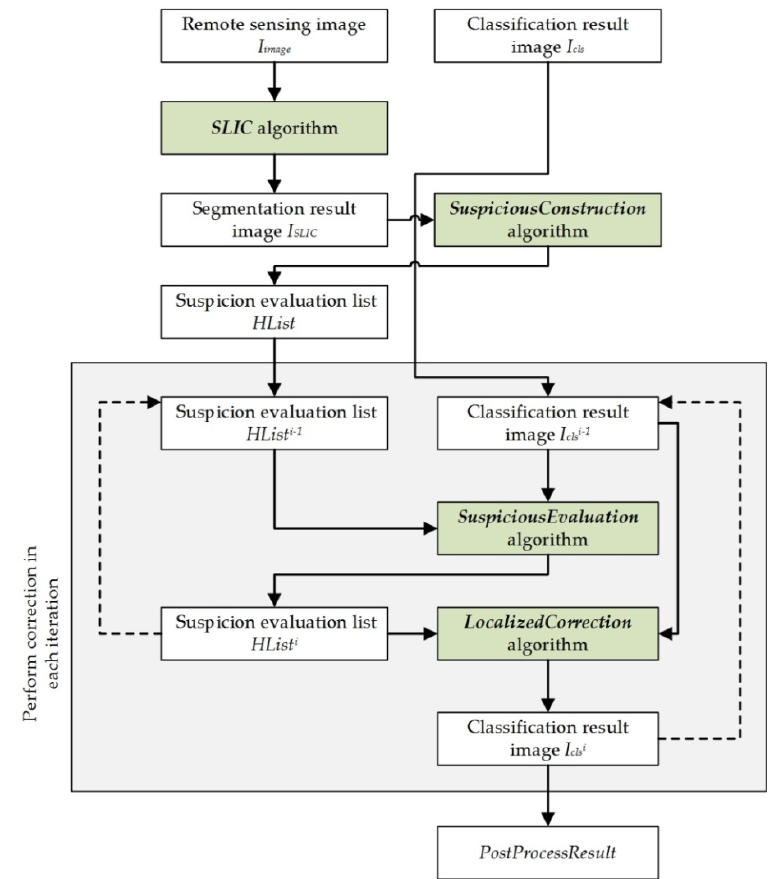
Figure 3. Overall processes of end ‐ to ‐ end and localized post ‐ processing method (ELP).